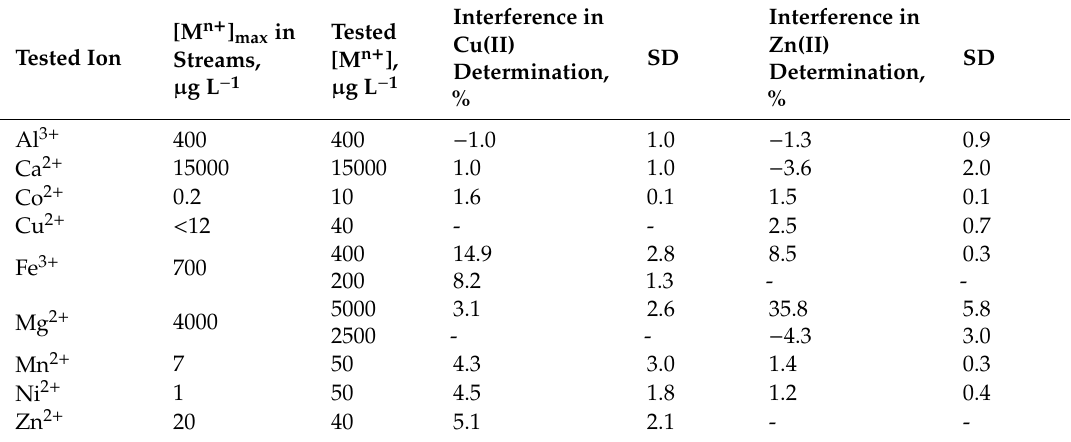
Table 1. Interference study of metal ions ([M n + ]) commonly present in environmental waters at their